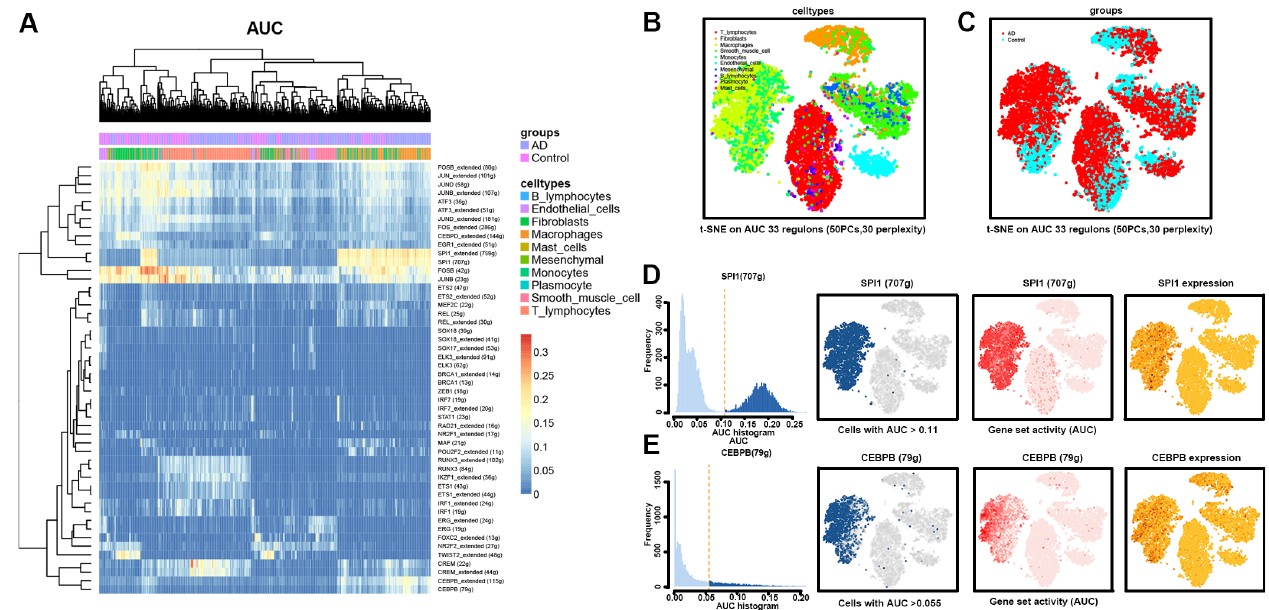
Figure 5. Transcriptional regulation of the 10 main cell types in the AD and normal groups. ( A ) Heatmap indicating expression regulation by TFs analyzed with SCENIC in the 10 main cell types. The numbers between brackets indicate the (extended) regulons for the respective TFs. ( B ) t-SEN plot showing the cell type distribution based on a dimensionality reduction by 33 regulons. ( C ) t-SEN plot showing the sample distribution based on a dimensionality reduction by 33 regulons. ( D ) Characterization of the AUC of the macrophage-associated transcriptional regulon SPI1. TF regulon activities were quantified using the AUC. ( E ) Characterization of the AUC of the macrophage-associated transcriptional regulon CEBPB. TFs, transcription factors; SCENIC, single-cell regulatory network inference and clustering; t-SNE, t-distributed stochastic neighbor embedding.